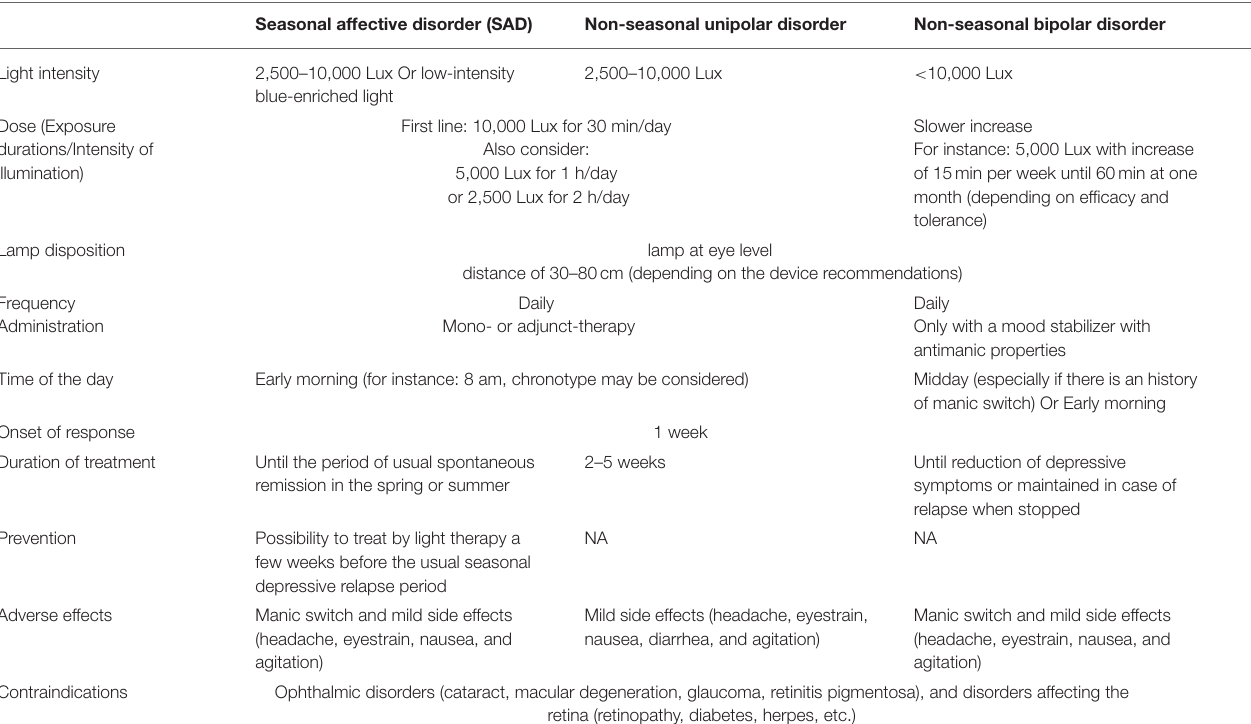
TABLE 1 | Forms of bright light therapy use in different mood